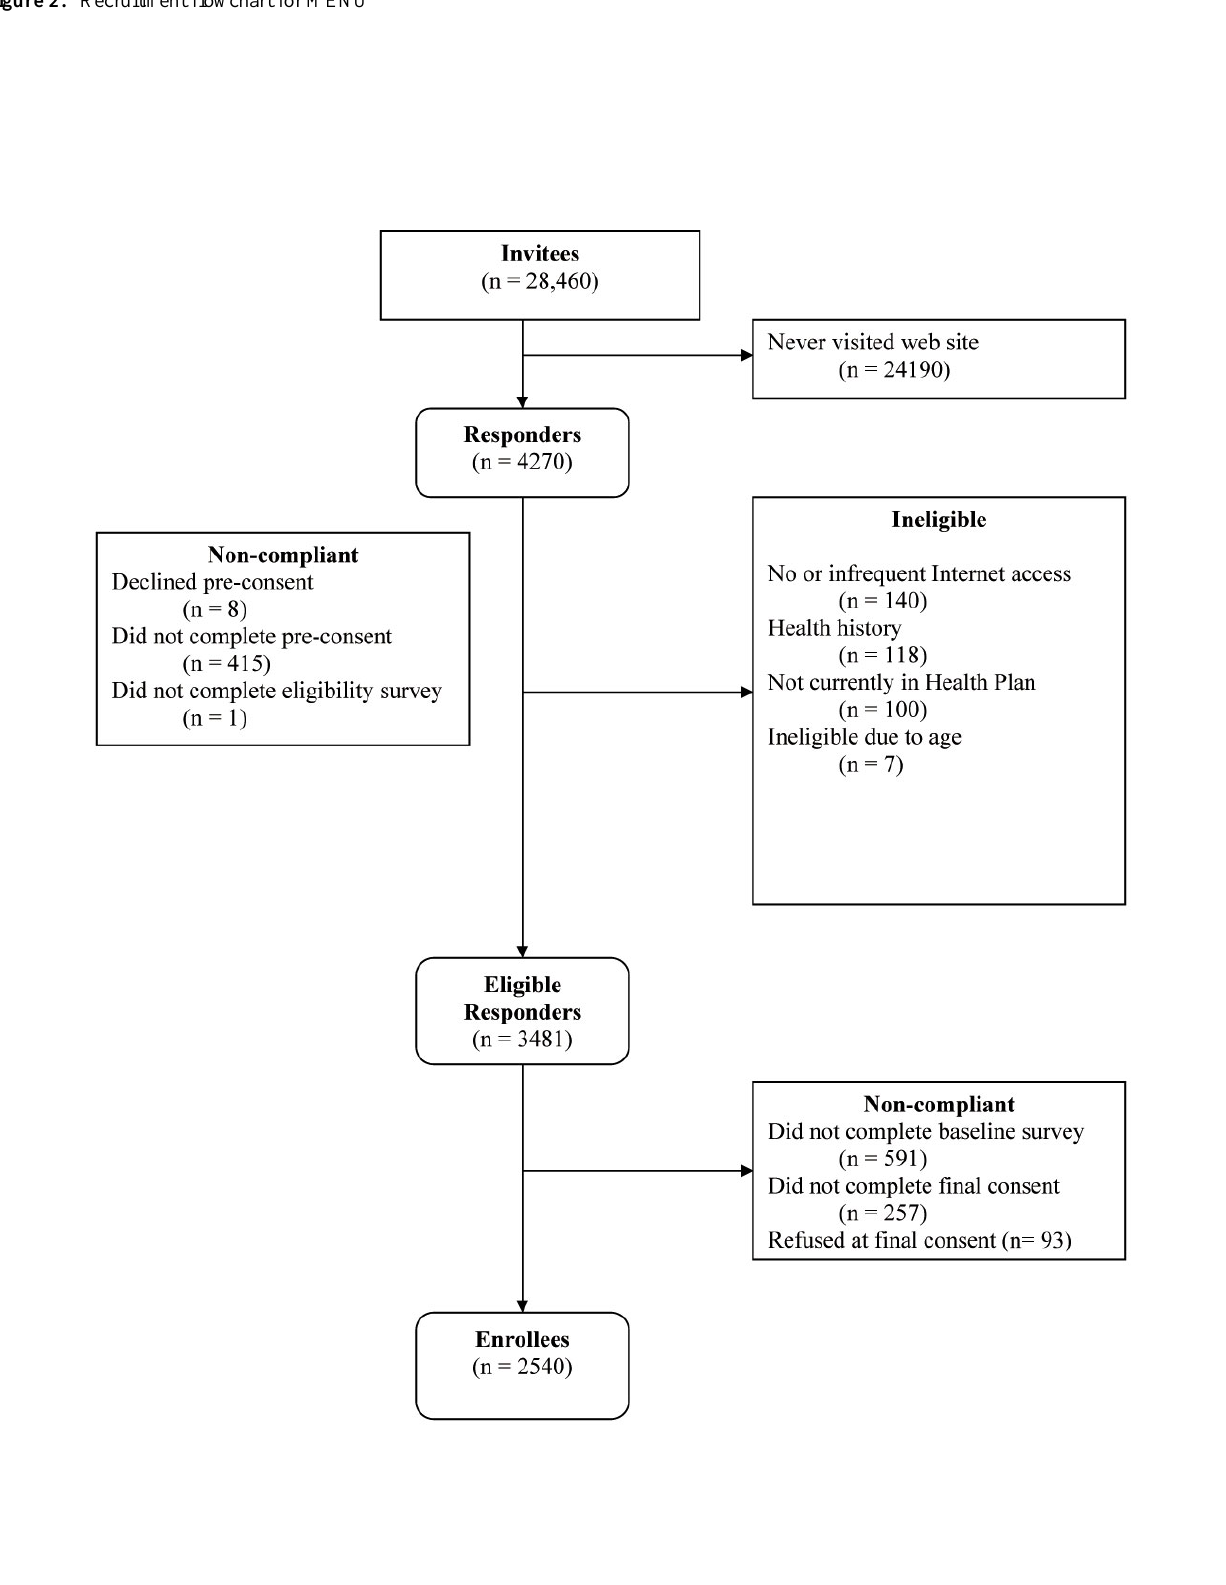
Figure 2. Recruitment flowchart for